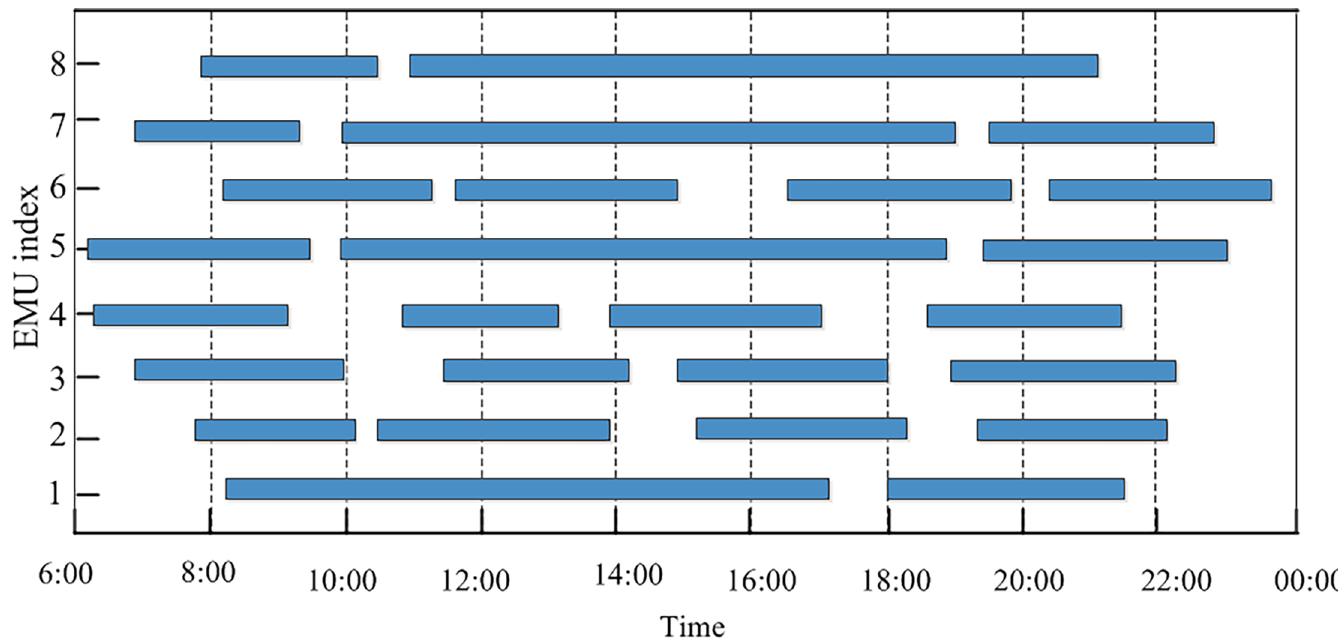
Fig 5. Gantt chart of the train tasks assigned to each EMU in the conventional